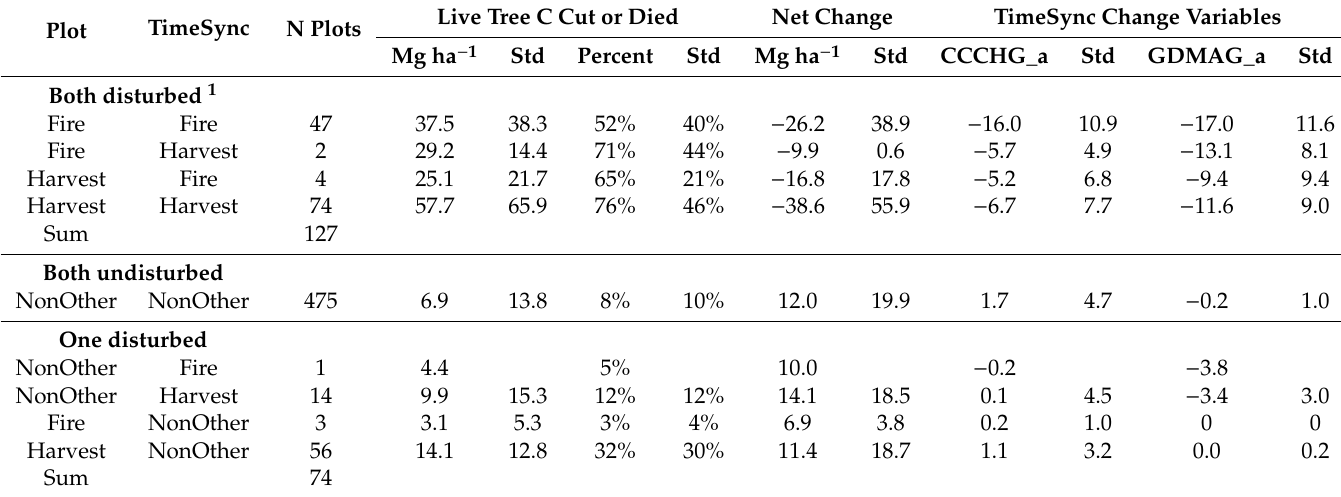
1 Bold headings group similar types of